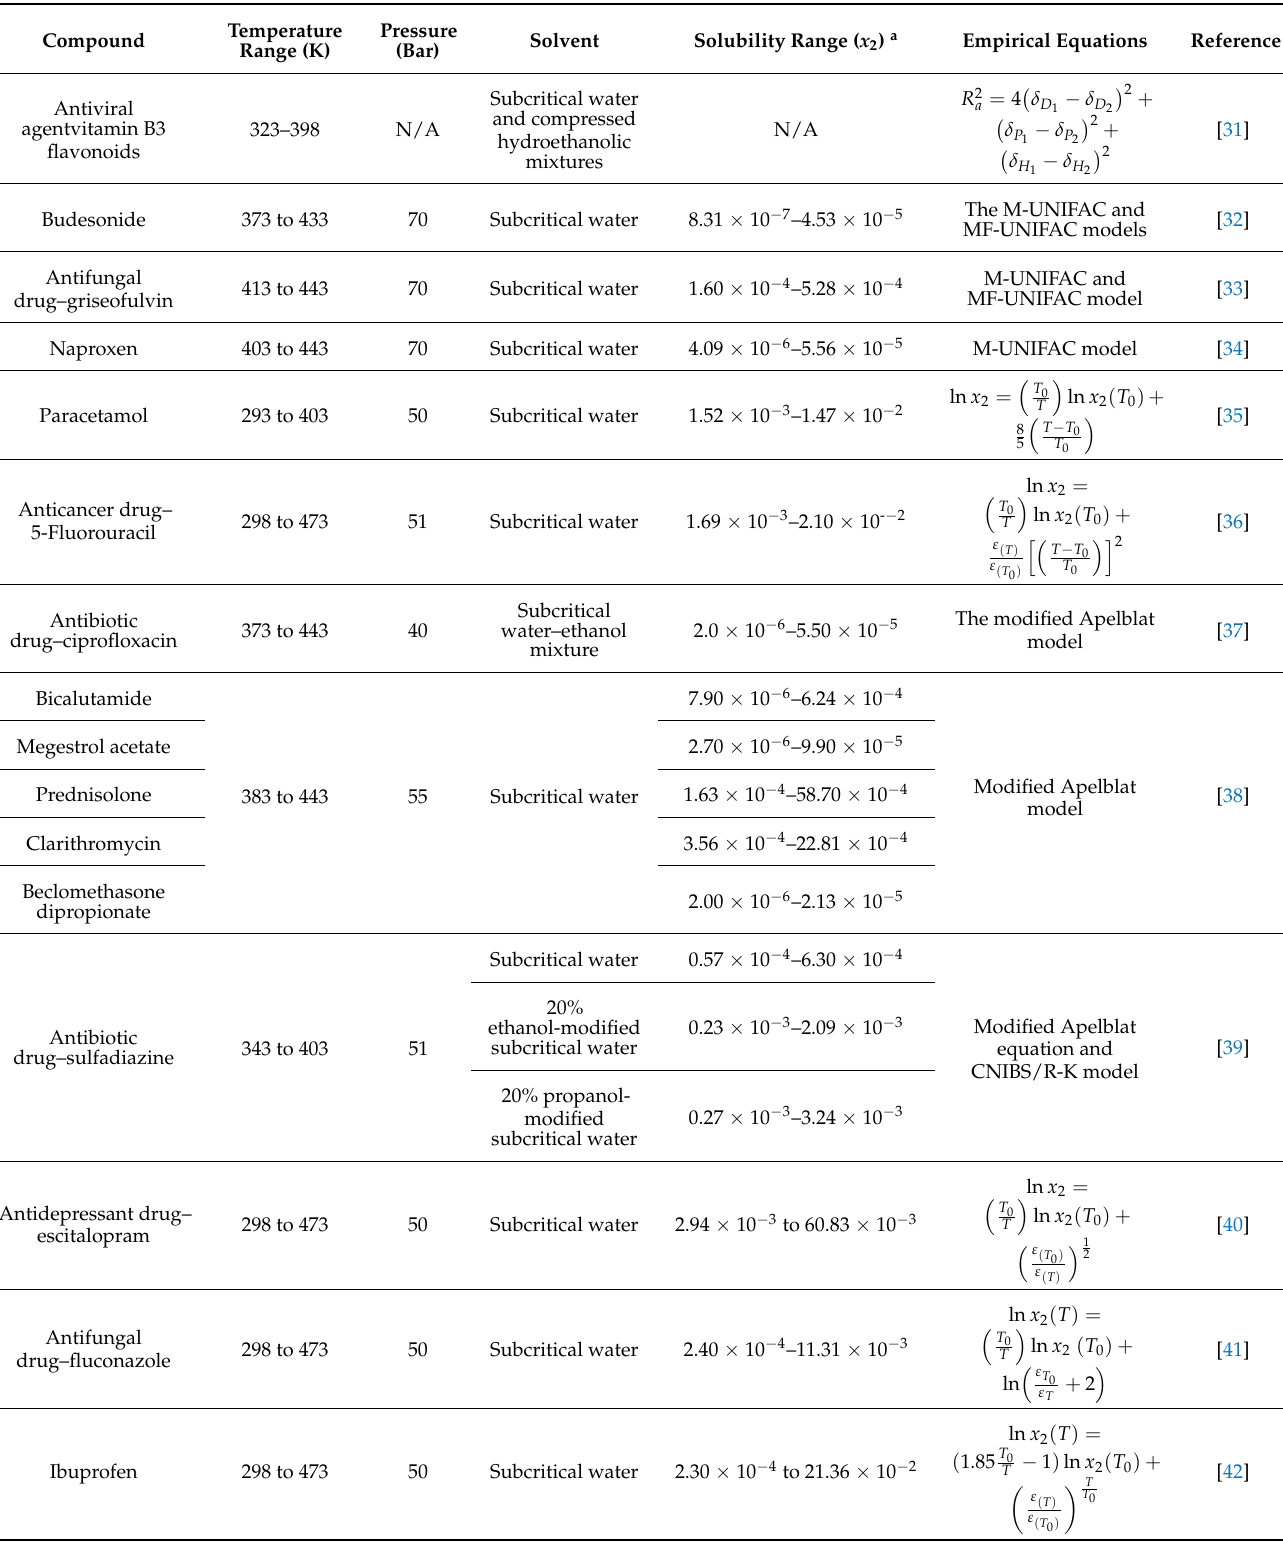
Table 4. Pharmaceutical solubilities in subcritical